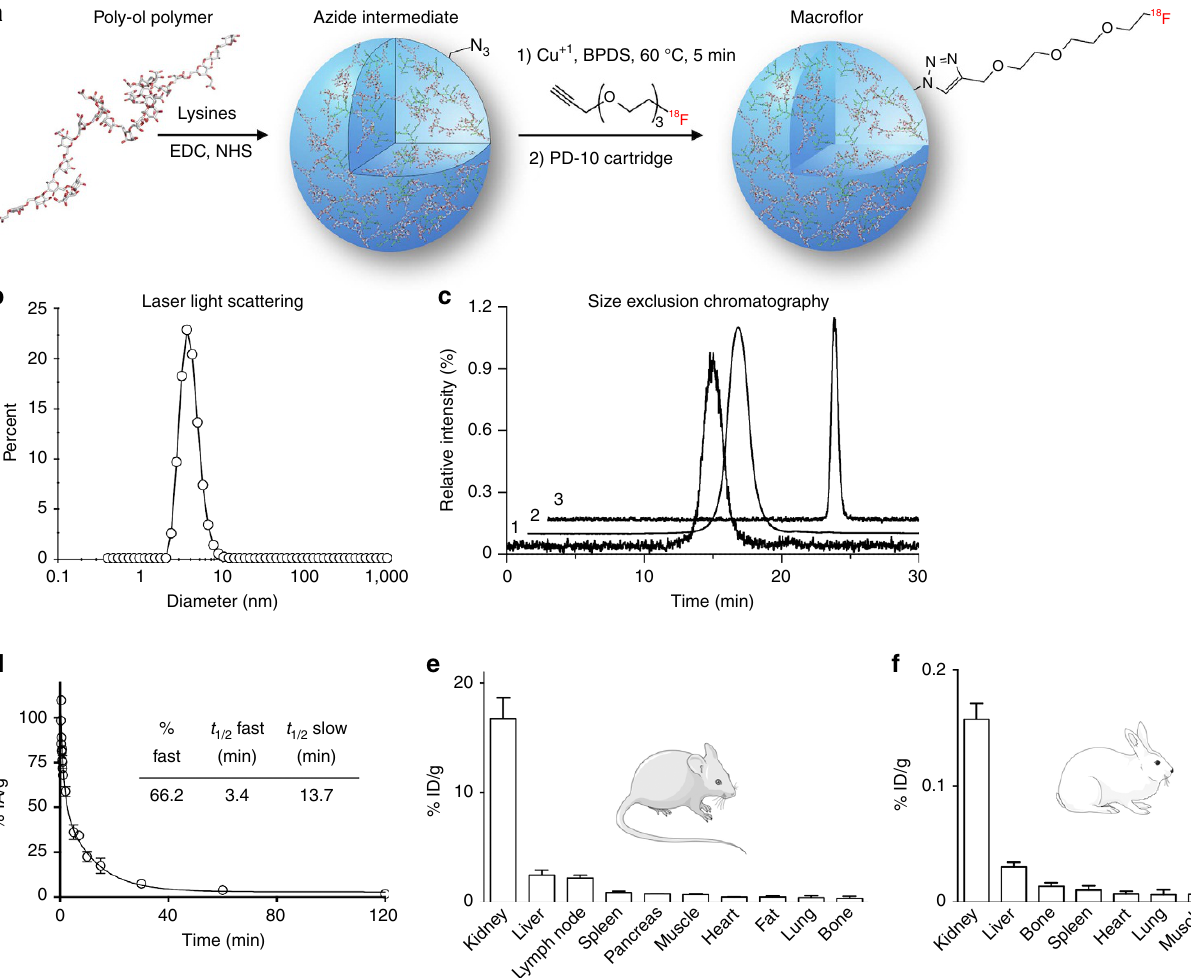
Figure 1 | Chemistry and pharmacokinetics in mice and rabbits. The figure describes synthesis, labelling, quality control and biodistribution in two species. ( a ) Synthesis and radiolabelling scheme. ( b ) Dynamic light scattering measurement of purified nanoparticle. ( c ) Size-exclusion chromatogram of purified labelled and unlabelled nanoparticles. ( d ) Blood half-life in wild-type mice ( n ¼ 5). ( e ) Biodistribution data in mice ( n ¼ 5) and ( f ) in normal rabbits ( n ¼ 4). Mouse and rabbit cartoon images are reproduced from the servier medical art image data bank